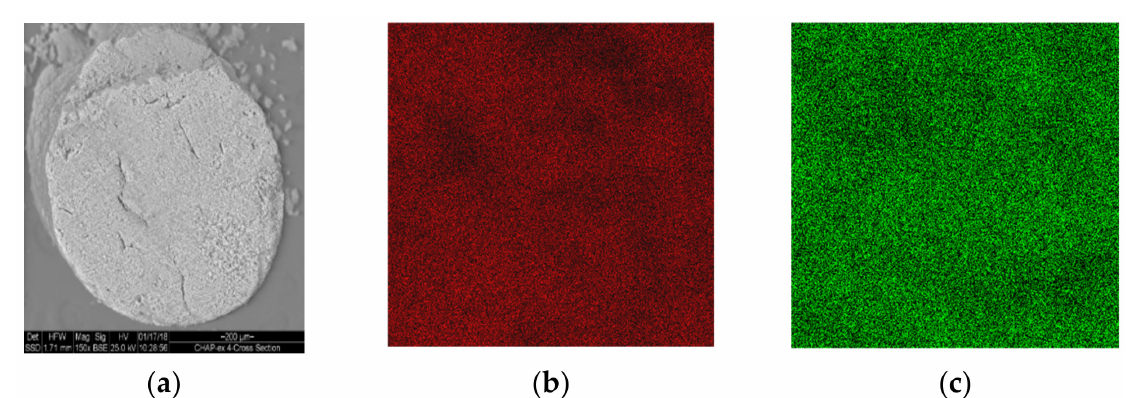
Figure 6. NH 3 - and CO 2 -TPD spectra recorded with HAP and C-HAP materials. The extrudates did not contain cracks (C-HAP-SiO 2 , Figure 7a) and displayed uniform distribution of C-HAP in their volume, as follows from Ca- and P- mapping of pellets cross sections in the SEM micrographs (Figure 7b,c). The texture characteristics of extrudates are listed in Table 2. Their surface area increased in the order of binders ZrO 2 < SiO 2 < Al 2 O 3 .